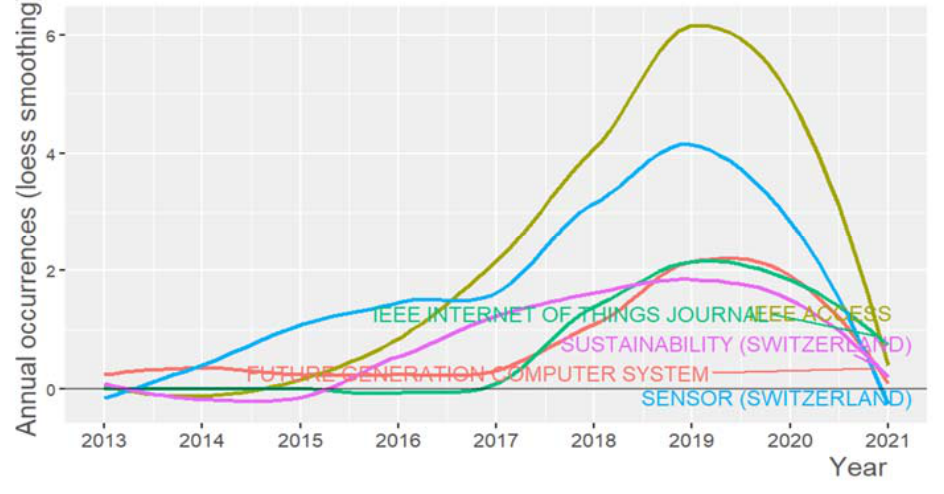
Figure 6. Source growth.